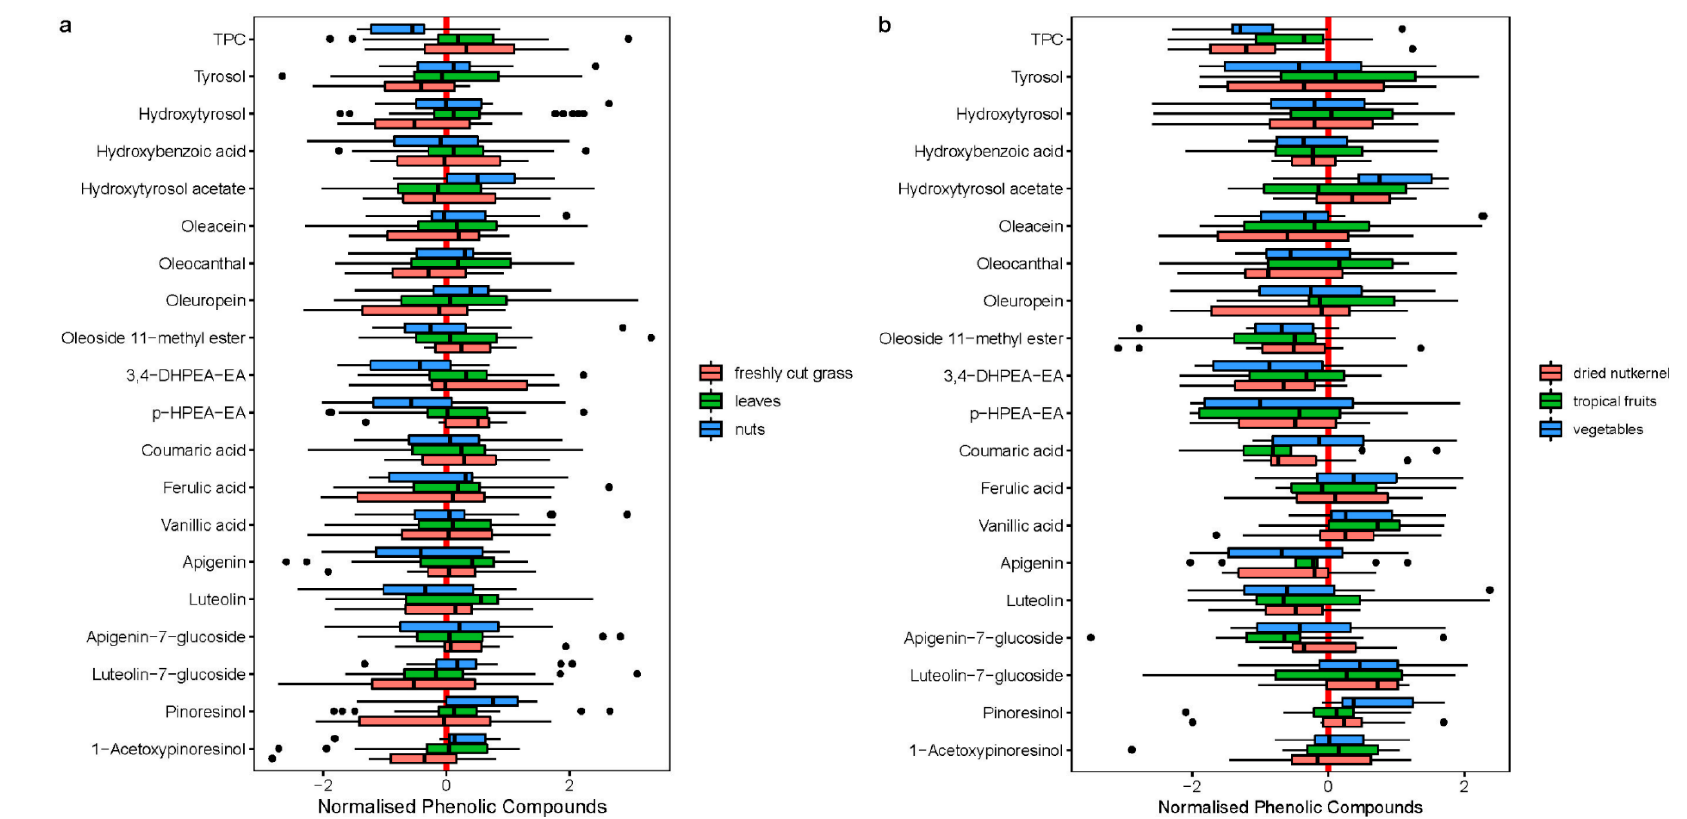
Figure 4. ( a ) Distribution of individual phenolic compounds between the three main occurring sensory descriptors leaves ( n = 38), nuts ( n = 22), freshly cut grass ( n = 13). ( b ) Distribution of individual phenolic compounds between the three rare occurring sensory descriptors dried nut kernel ( n = 12), vegetables ( n = 12), and tropical fruits ( n = 10).